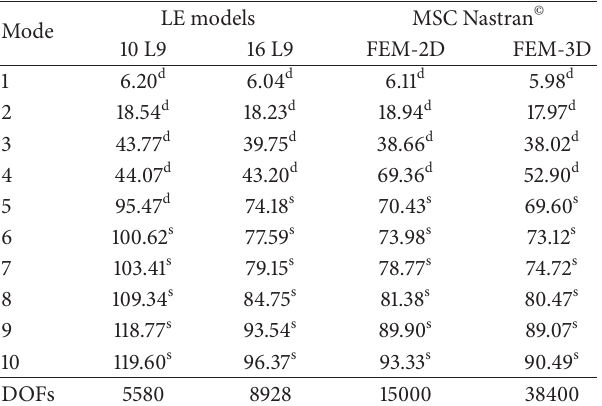
Table8:First 10 naturalfrequencies(Hz)forthehollow-rectangular box beam with two localized masses at the tip cross-section (Figure 20(b), Case